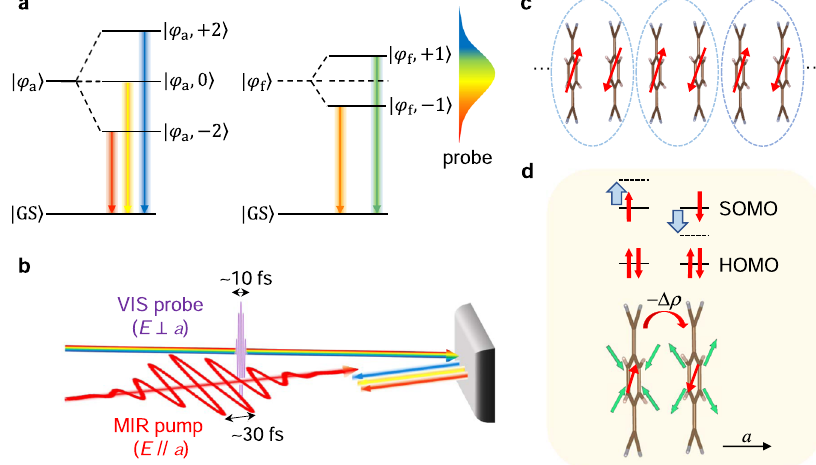
Fig. 1 Observation of phonon-dressed states in a dimerized organic Mott insulator of K-TCNQ. a Schematic energy levels of phonon-dressed states. | φ a 〉 (| φ f 〉 ) is an originally one-photon-allowed (forbidden) excited state and |GS 〉 is a ground state. | φ a,f , n 〉 is an n -phonon-dressed state. Colored arrows show light emissions from phonon-dressed states. b Schematic of the mid-infrared (MIR)-pump visible (VIS)-re fl ectivity-probe measurement. c A 1D dimerized TCNQ − stack in K-TCNQ. d Schematic of an out-of-phase intramolecular vibration ( a mode) in a dimer, which is infrared-activated via the electron- g intramolecular-vibration (EMV) coupling. This out-of-phase vibration modulates singly occupied molecular orbital (SOMO) levels and induces a partial charge transfer (cid:2)4 ρ < 0